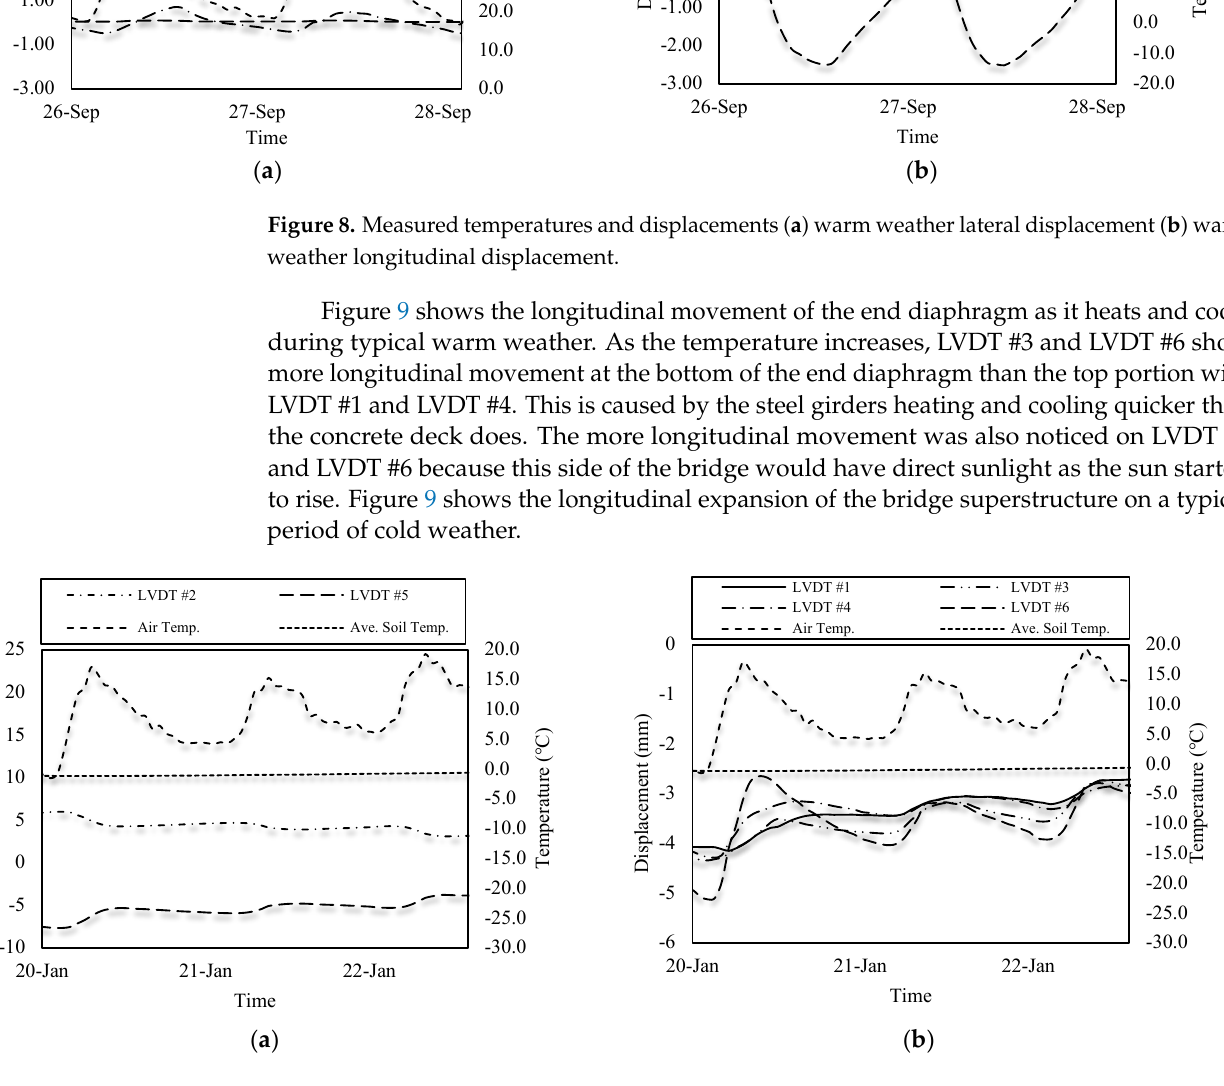
Figure 9. Measured temperatures and displacements ( a ) cold weather longitudinal displacement ( b ) cold weather lateral displacement.